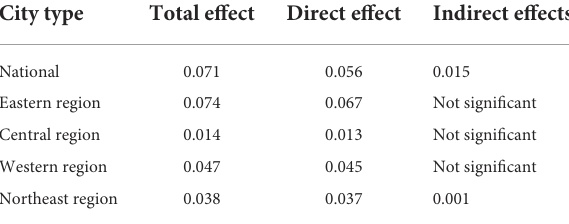
TABLE 8 The path test result of land finance impacting on economic